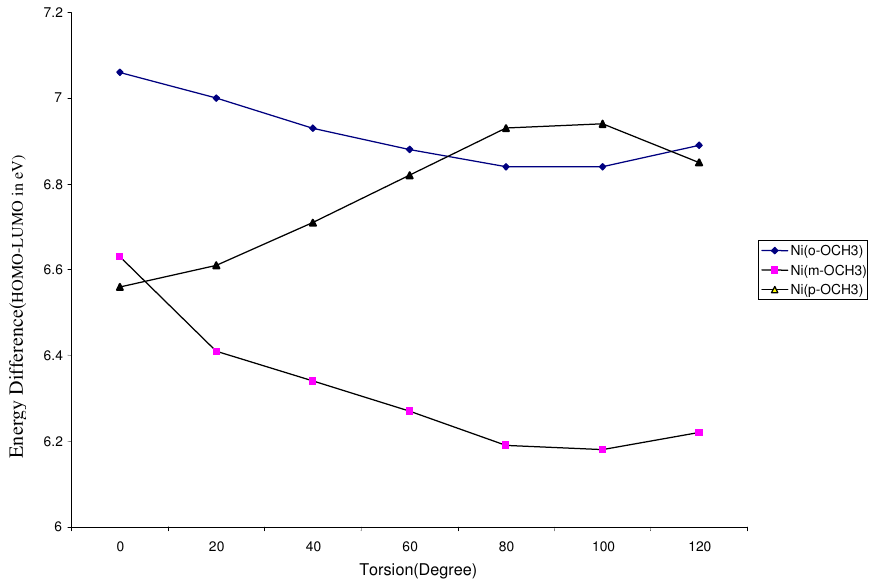
Figure 8. Evolution of HOMO-LUMO energy difference as a function of torsion angles for un-substituted, ortho, meta and para- methoxyl Ni[C However, in the case of un-substituted and methyl substituted Cu[C curves are quite similar to that of Ni[C torsion angles become larger in un-substituted and ortho -methyl substituted (Figure 9). In Figure 10, methoxyl substituent has the same effect on the π - electrons delocalization of benzoic rings in the Cu(II) complexes. Calculated Mulliken charges on copper and Nickel atoms are -0.494 ~ -0.351 and -0.974 ~ -1.061 respectively. The charge on copper atom increases on addition of methyl and methoxyl substituents, the effect is more pronounced with methoxyl substituent especially on meta and para positions. However, o- OCH little effect on atomic charge of copper which may due to formation of hydrogen bond. The atomic charge on nickel reduces slightly except o- OCH